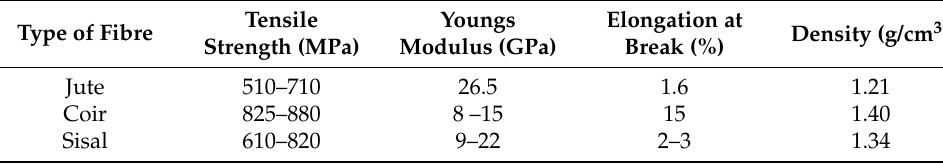
Figure 3. Fibres utilized: ( a ) Jute; ( b ) Coir; ( c ) Sisal. Table 1. Properties of fibres.